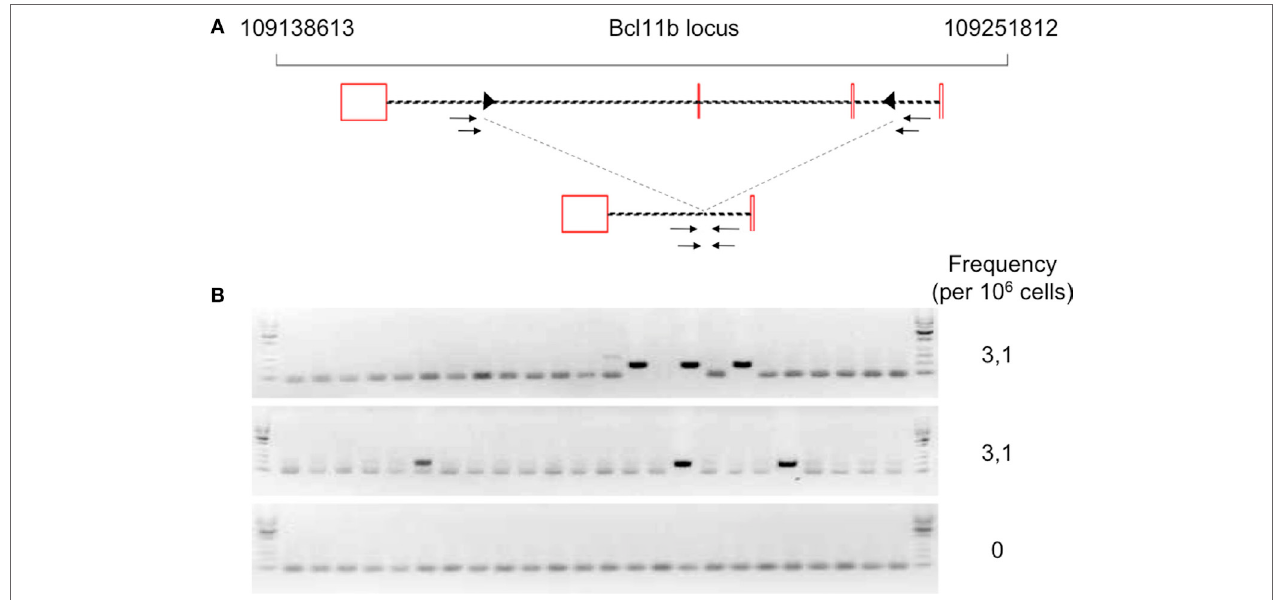
FigUre 4 | Occurrence of Bcl11b cryptic recombination in 4-hydroxytamoxifen (TAM)-induced Tg endoR2 − / − animals. (a) Bcl11b locus, cryptic recombination sites and nested primers used in the fluctuation PCR analysis. Bcl11b exons are represented by red boxes, with introns represented as dashed lines connecting these boxes (note that bcl11b is on the reverse strand); cRSS are depicted as triangles within the introns, and primers used for the nested PCR are depicted by arrows. The bottom line shows an illegitimate Bcl11b recombination. (B) Fluctuation PCR analysis for each mouse concerned 24 reactions, each with 240 ng of genomic DNA, equivalent to a total of 0.96 million cells. Each row is the analysis of the total thymocytes of one Tg endoR2 − / − TAM + mice. Recombination was detected in two out of three mice, at the frequency indicated in the right